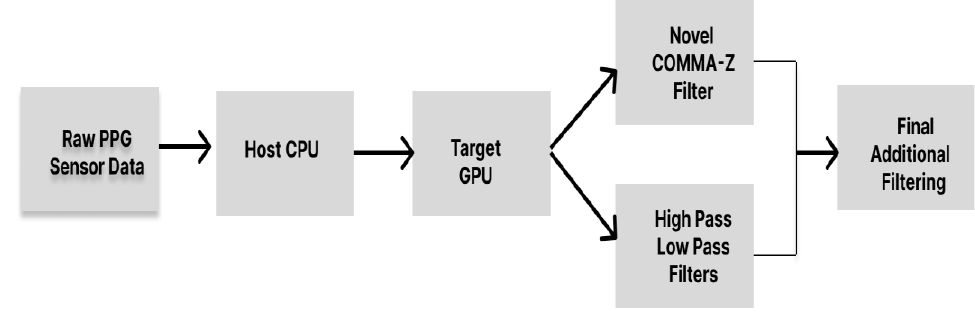
Figure 2. Proposed System Design using GPU and